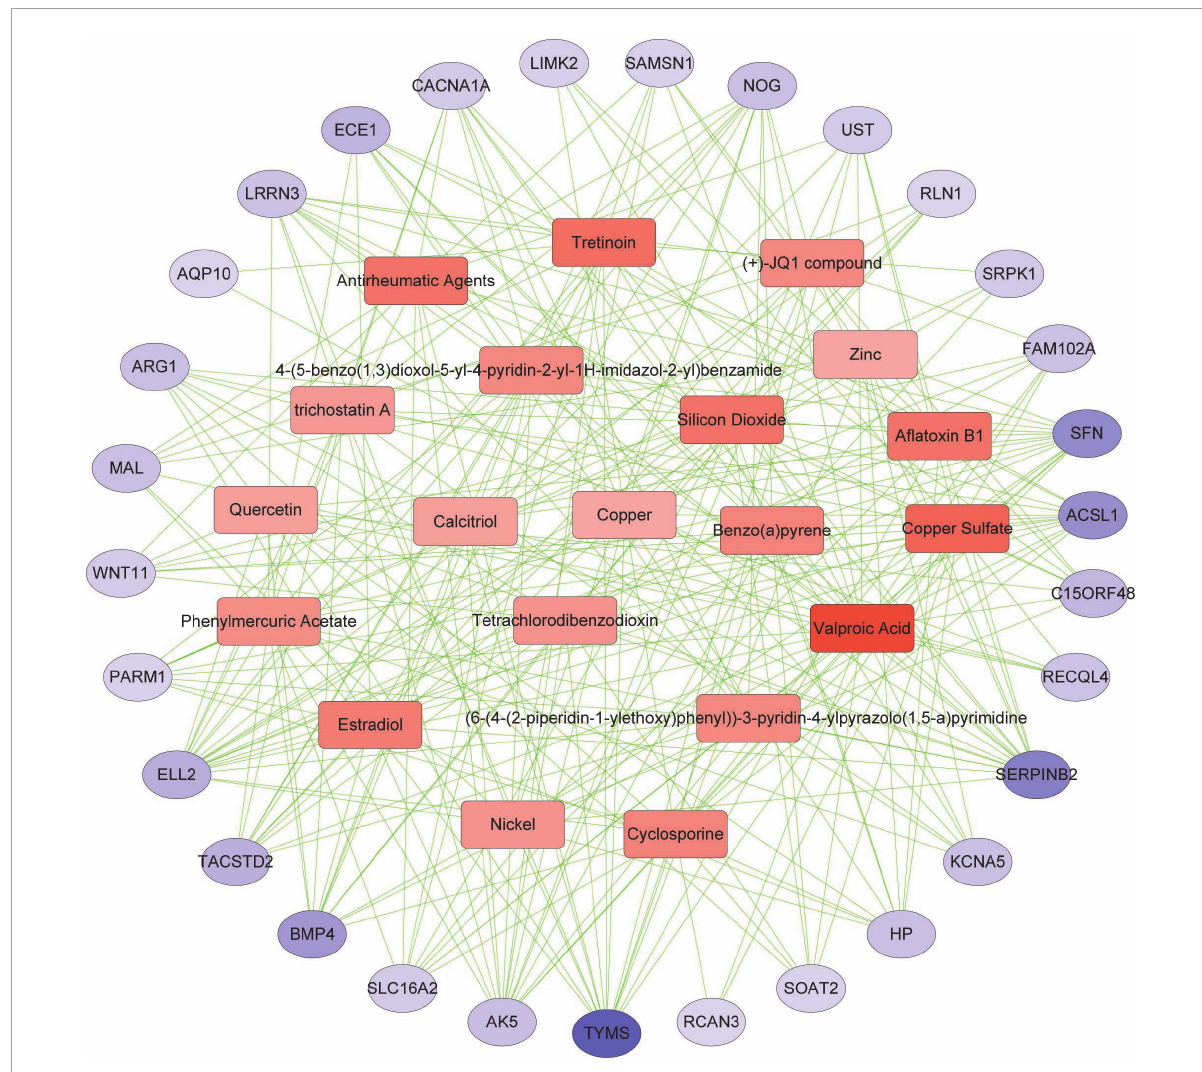
FIGURE7 Association between COVID-19 and AF from the perspective of protein and chemical compounds. Circles represent proteins and squares represent compounds. nodes with top50 connectivity are shown, and nodes with high connectivity are presented in darker colors.